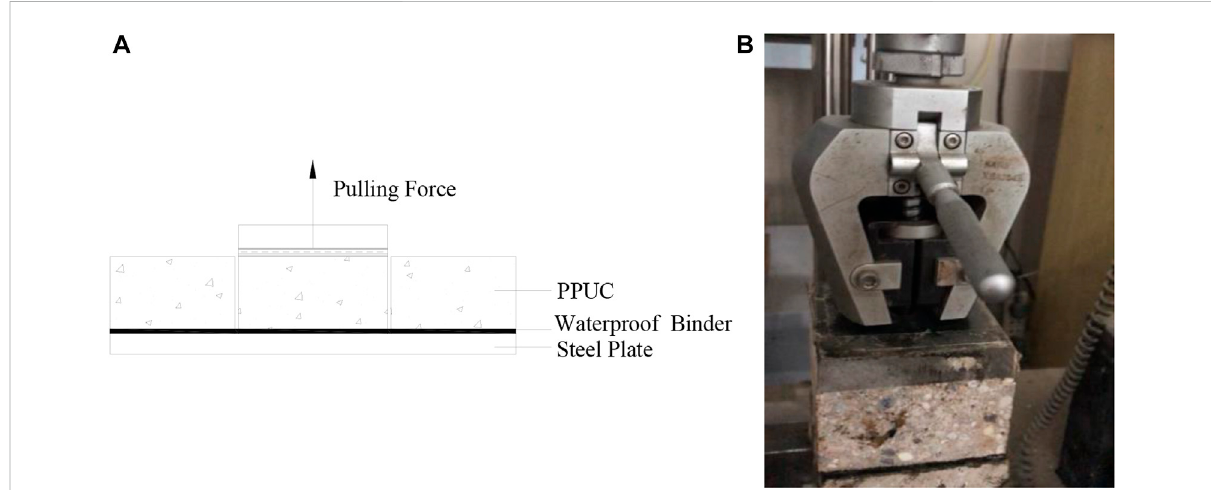
FIGURE 11 Pull-out test procedure. (A) Schematic diagram of the pull-out test; (B) Test set up of the pull-out test.